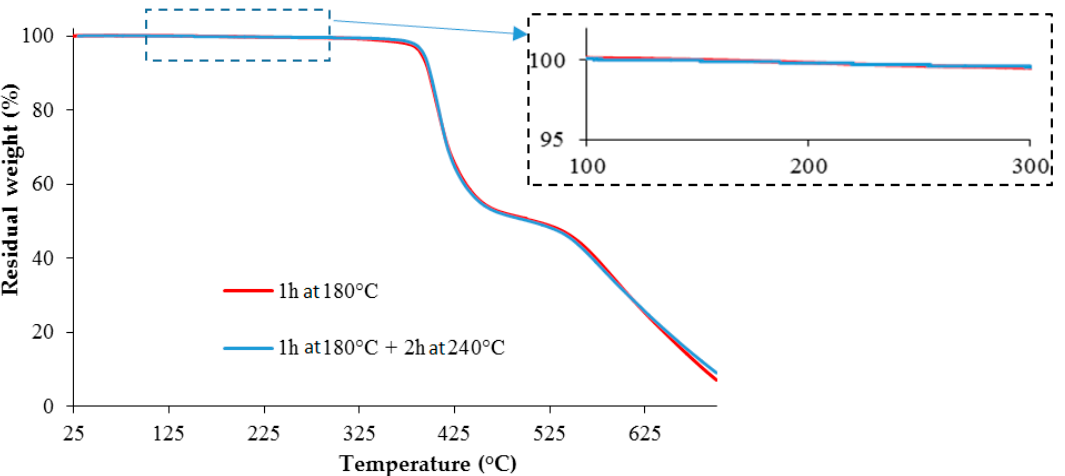
Figure 22. Comparison of two TETM/DDS samples cured under different curing cycles, by TGA, at a heating rate of 10 °C/min, under air.